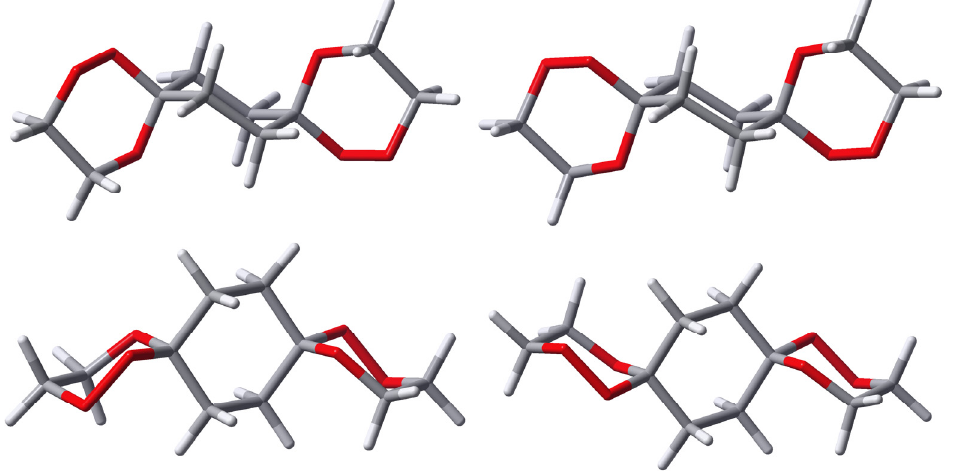
Figure 5 . Calculated structures of anti - 9 (OO) Each conformer is shown from two perspectives (upper and lower